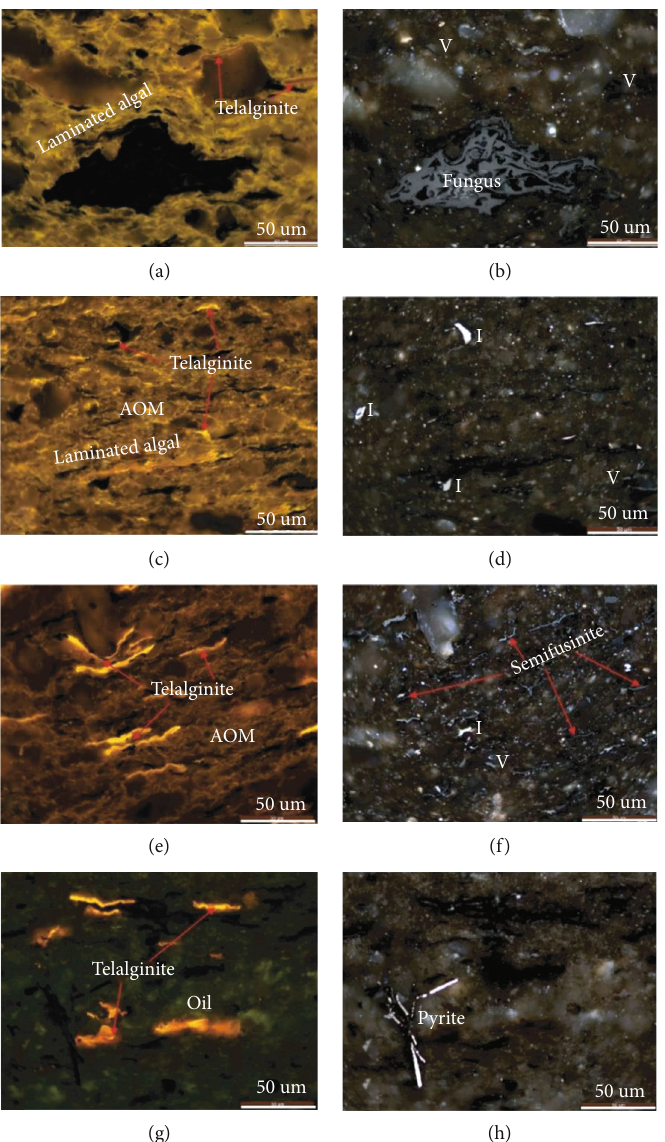
Figure 5: Photomicrographs showing AOM, V, I, laminated algal, telalginite, semifusinite, fungus, oil, and pyrite in the Permian Lucaogou sediments from the Junggar Basin: (a) fl uorescent light, J10025, 3586.2m, shale; (b) same fi eld as (a) under re fl ected light; (c) fl uorescent light, J10025, 3600.5m, shale; (d) same fi eld as (c) under re fl ected light; (e) fl uorescent light, J10025, 3670.1m, shale; (f) same fi eld as (e) under re fl ected light; (g) fl uorescent light, J10025, 3675.25m, shale; (h) same fi eld as (g) under re fl ected